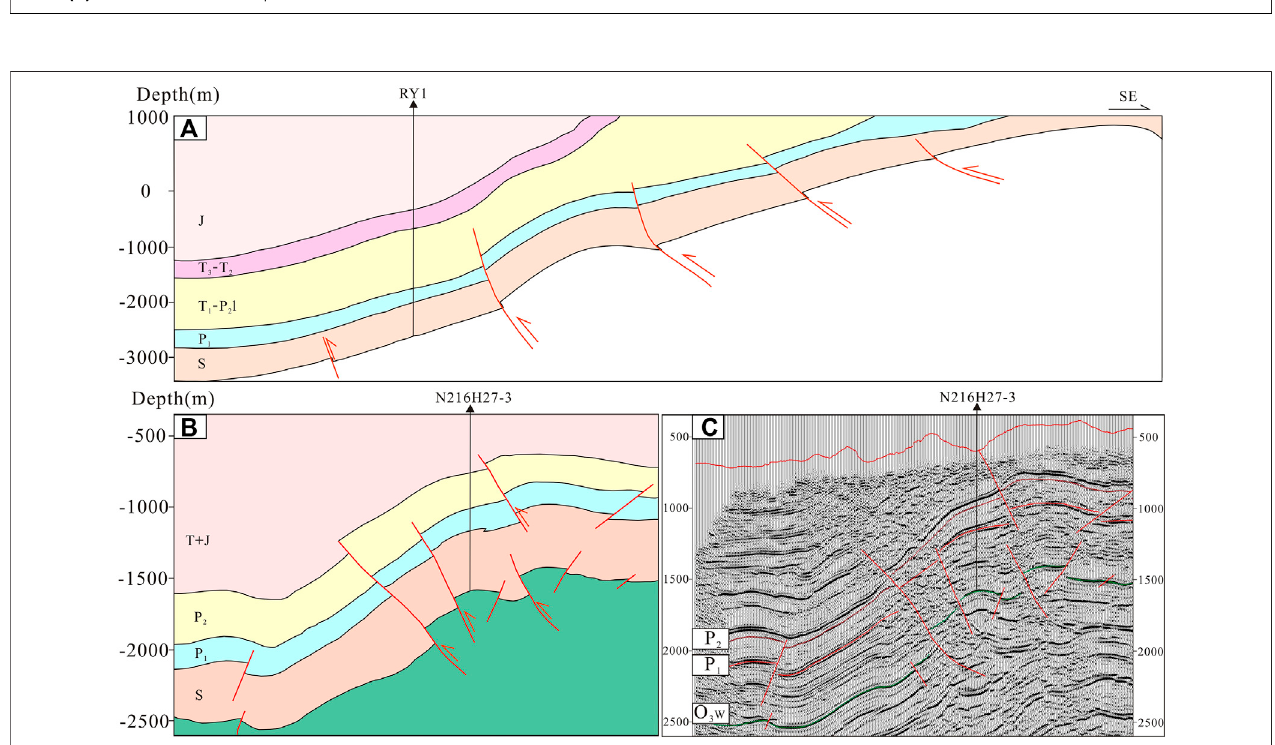
FIGURE5| Basinmargin fault blocks slopegas-richstructure. (A) CrossRY1 wellpro fi leinRenhuaiarea. (B) Cross N216H27-3wellpro fi leinChangningarea. (C) Cross N216H27-3 well seismic pro fi le in Changning area.